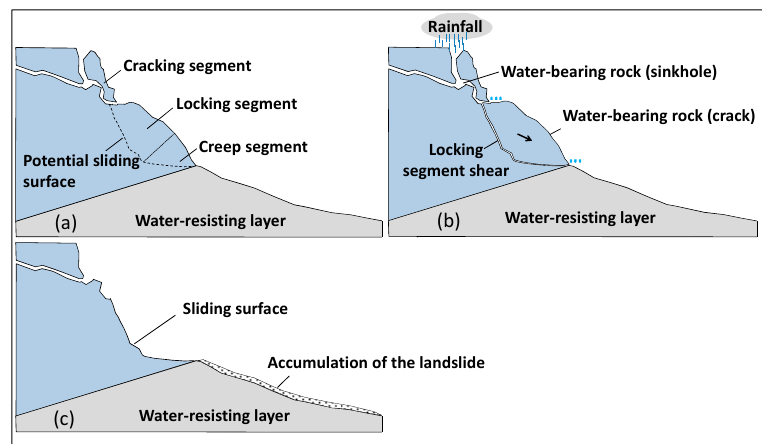
Figure 12. ( a – c ) Diagrammatic sketch of the mountain structure and failure mode of creep body